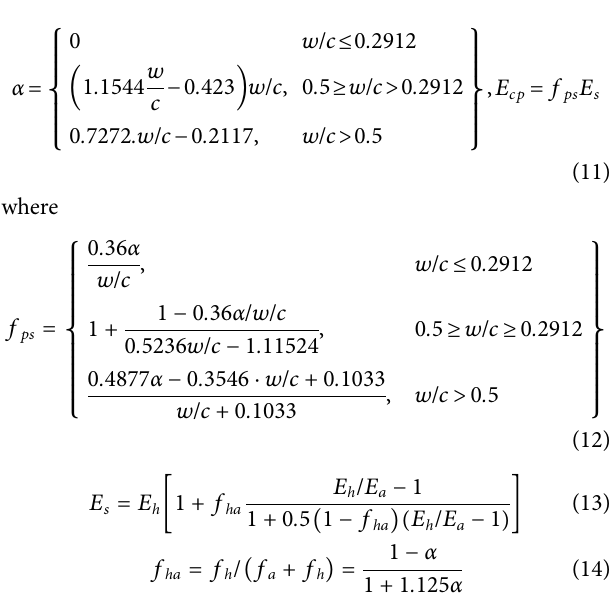
FIGURE 5 | Percolation thresholds based on Powers ’ s model, Eq. 3 , and experimental results of Boumiz et al. (1996) for different w/c ratios.